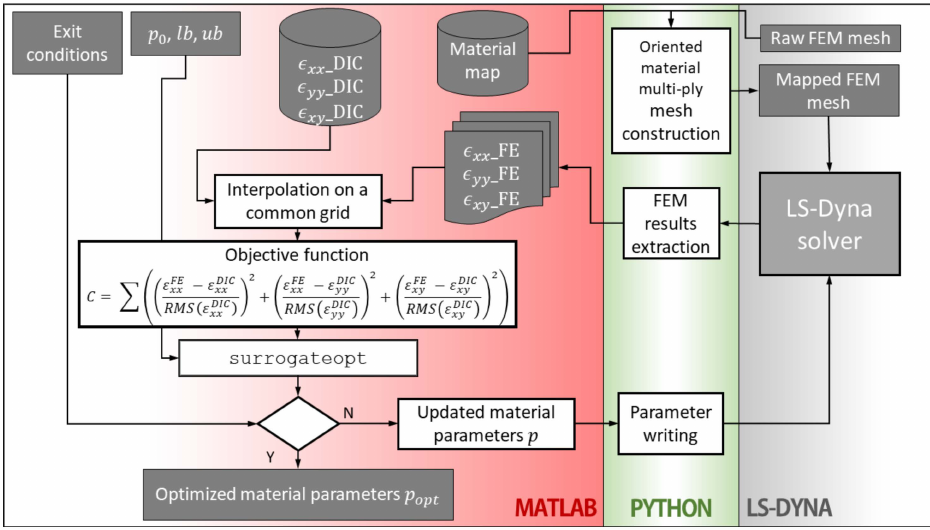
Figure 4. Flowchart of the optimization